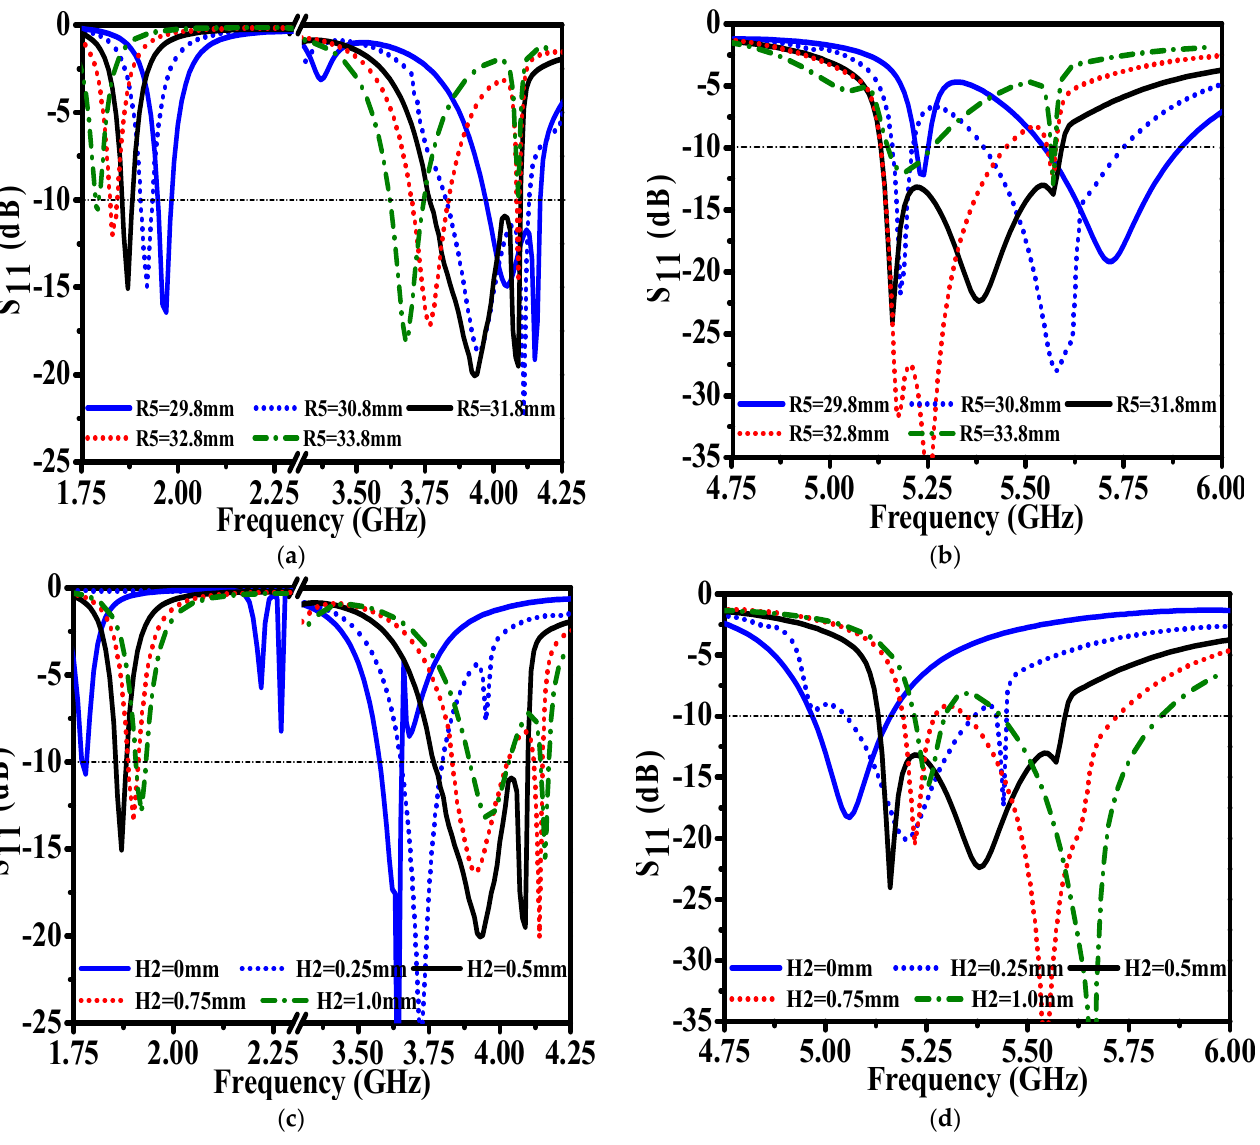
Figure 5. The effect of different parameters on simulated S 11 of Ant. 3: ( a ) the effect of different R5 on frequency bands f 1 and f 2 ; ( b ) the effect of different R5 on frequency band f 3 ; ( c ) the effect of different H 2 on frequency bands f 1 and f 2 ; ( d ) the effect of different H 2 on frequency band f 3 .